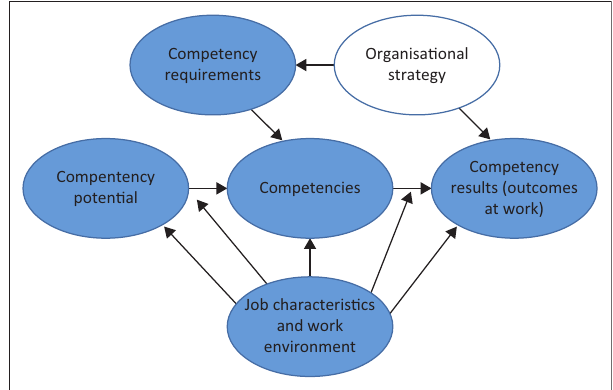
FIGURE 1: A graphical representation of a chain of cause-and-effect relationships between variables mapped in a three-domain competency model.